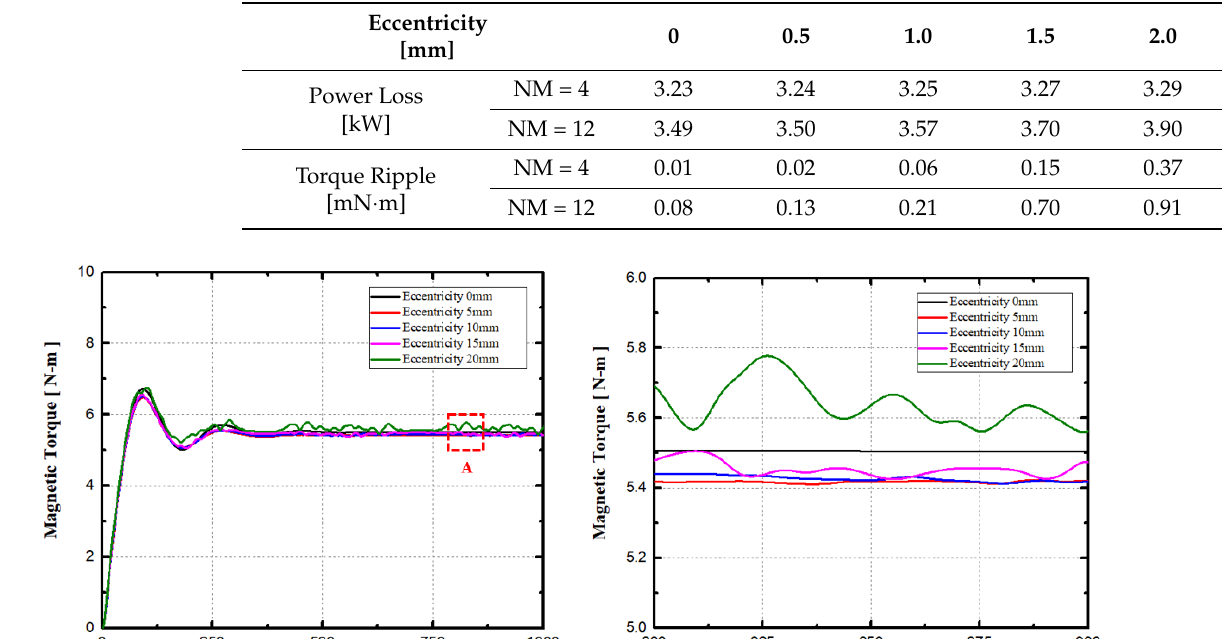
Figure 13. Changes in current density according to eccentricity. Table 6. Mean heating value and torque ripple in the billet. (NM = Number of magnets).